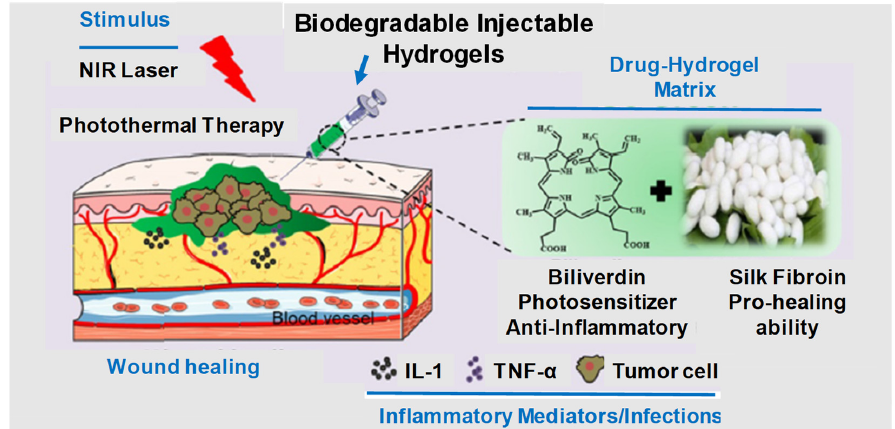
Figure 2. Graphical illustration depicting the design and fabrication of injectable hydrogel for photothermal antitumor therapy and following wound repair and regeneration. Adapted with permission from ref. [10]. Copyright © 2020 Theranostics